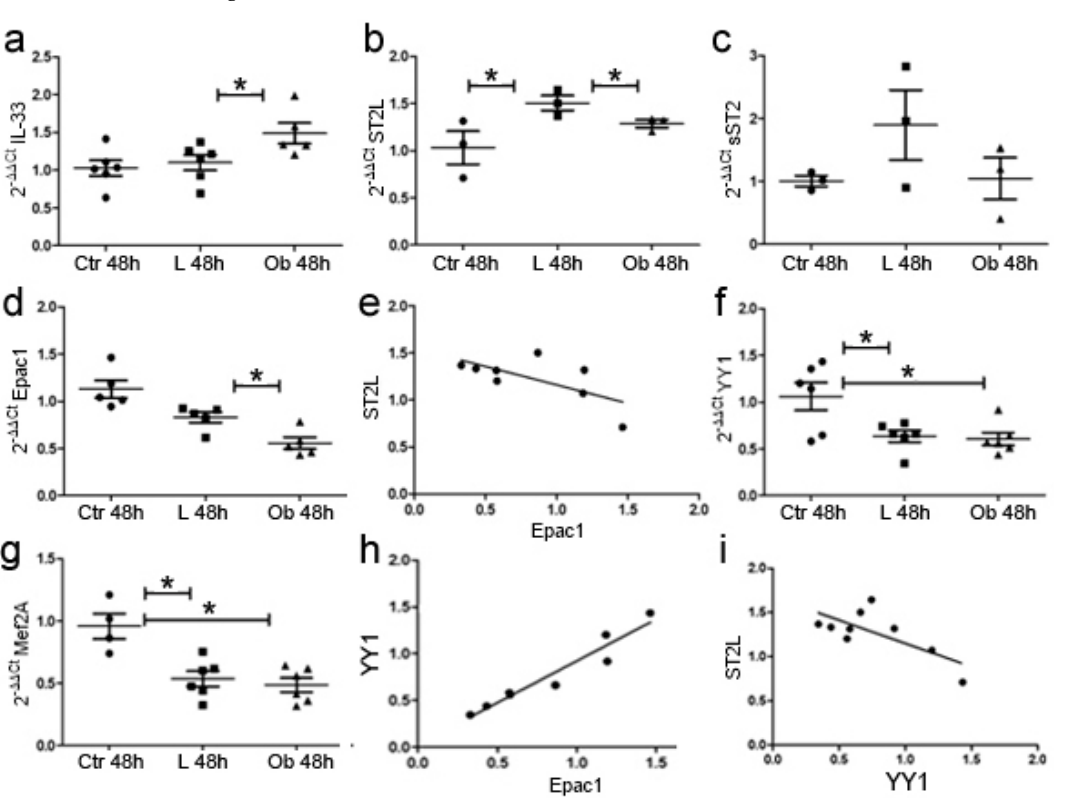
Figure 6. Conditioned medium with VAT tissue promotes cardiomyocytes’ gene expression alteration and hypertrophic/fibrotic signaling. qPCR experiments showed that fat stimulation from Obese rats promoted ( a ) IL-33 expression while it reduced ( b ) ST2L . ( c ) sST2 was not modified. Fat stimulation reduced ( d ) Epac1 expression. ( e ) The graph showed a negative—but not significant—correlation between ST2L and Epac1 expression. Fat stimulation reduced ( f ) YY1 expression in both Lean and Ob and ( g ) Mef2A expression in both Lean and Ob versus CTR. ( h ) The graph showed a positive correlation between YY1 and Epac1 while ( i ) a negative correlation emerged between ST2L and. Student’s t -test: * p < 0.05. Full square stands for Obese rats, while full circle stands for Lean rats. Conversely, stimulation of adipose tissue with obese-derived VAT determined a slight reduction in the expression of ST2L while soluble sST2 did not vary, suggesting deregulation in IL-33/ST2L pathway due to obesity (Figure 6b,c). Finally, Epac1 expression was reduced in cells cultured with obese-derived VAT—in line with data obtained in cardiac biopsies—and negatively correlated to ST2L expression ( p < 0.001) (Figure